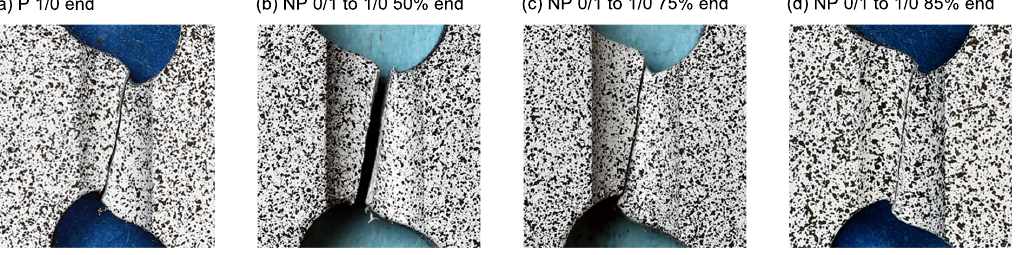
Figure 9. Fracture lines.